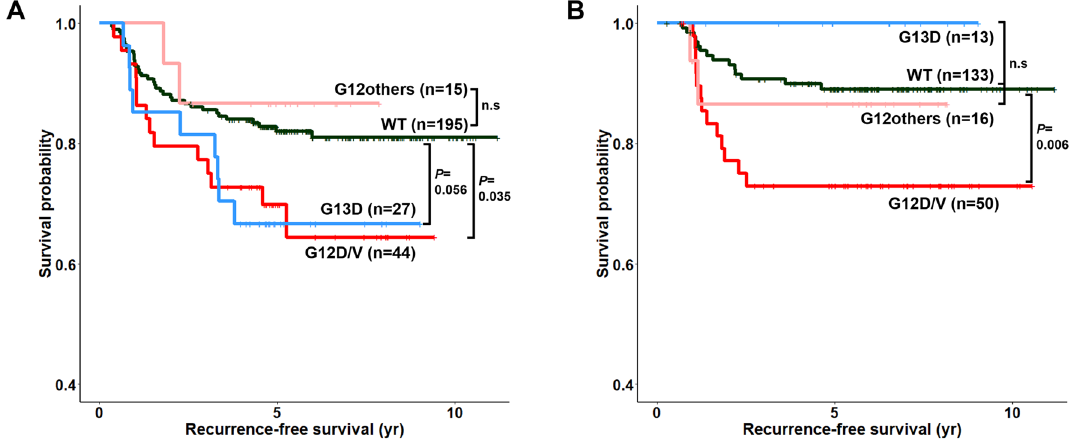
Figure 4. Recurrence-free survival according to the KRAS mutation status. Kaplan–Meier survival curve of the ( A ) discovery cohort and ( B ) validation cohort.